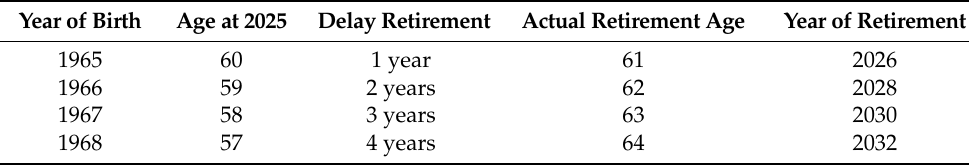
Table 7. Delayed retirement plan I (male workers).